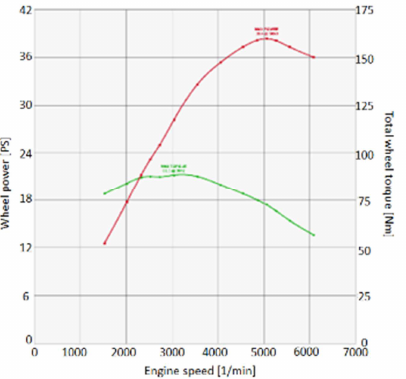
Fig. 1. Exemplary waveforms of measured engine power and torque as a function of engine speed for the tested engine The diagram of the valve lift as a function of the angle of camshaft rotation is shown in Fig. 2. This graph also shows the modelled course of pressure in the cylinder in the initial phase of opening the outlet valve. A high pressure drop is then observed as a function of the angle of camshaft rotation.